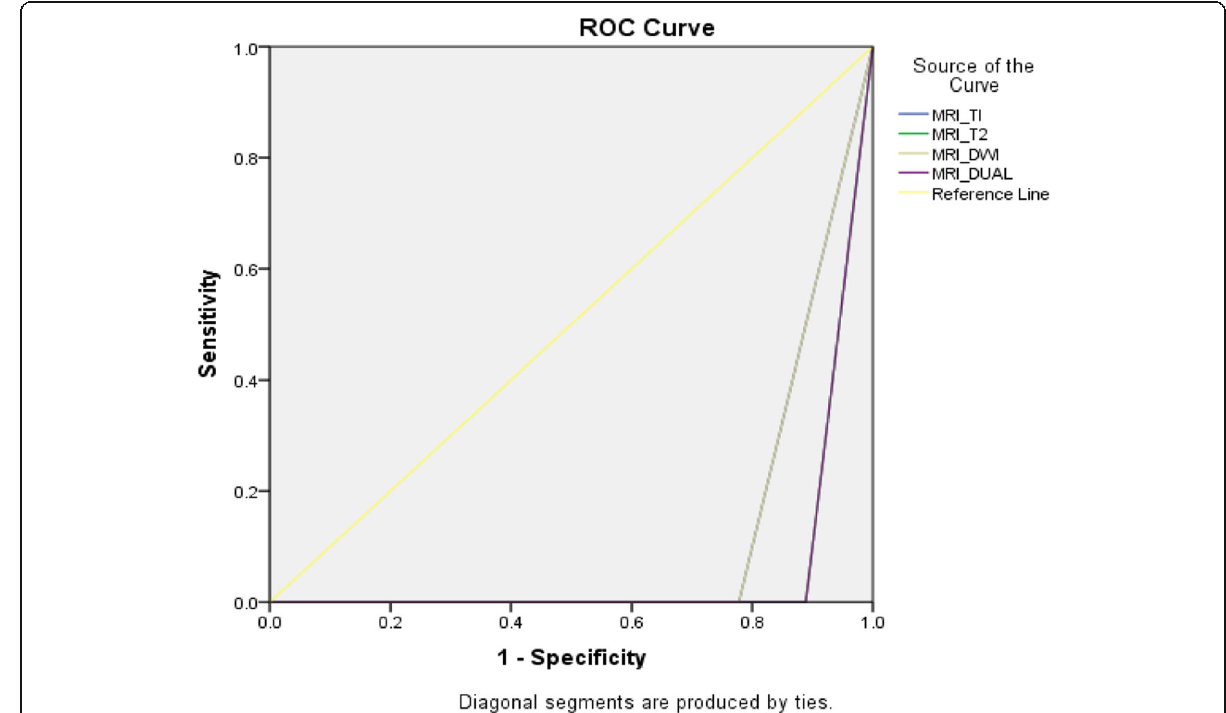
Fig. 3 MRI sequences diagnostic value/validity in lipid-rich benign lesion